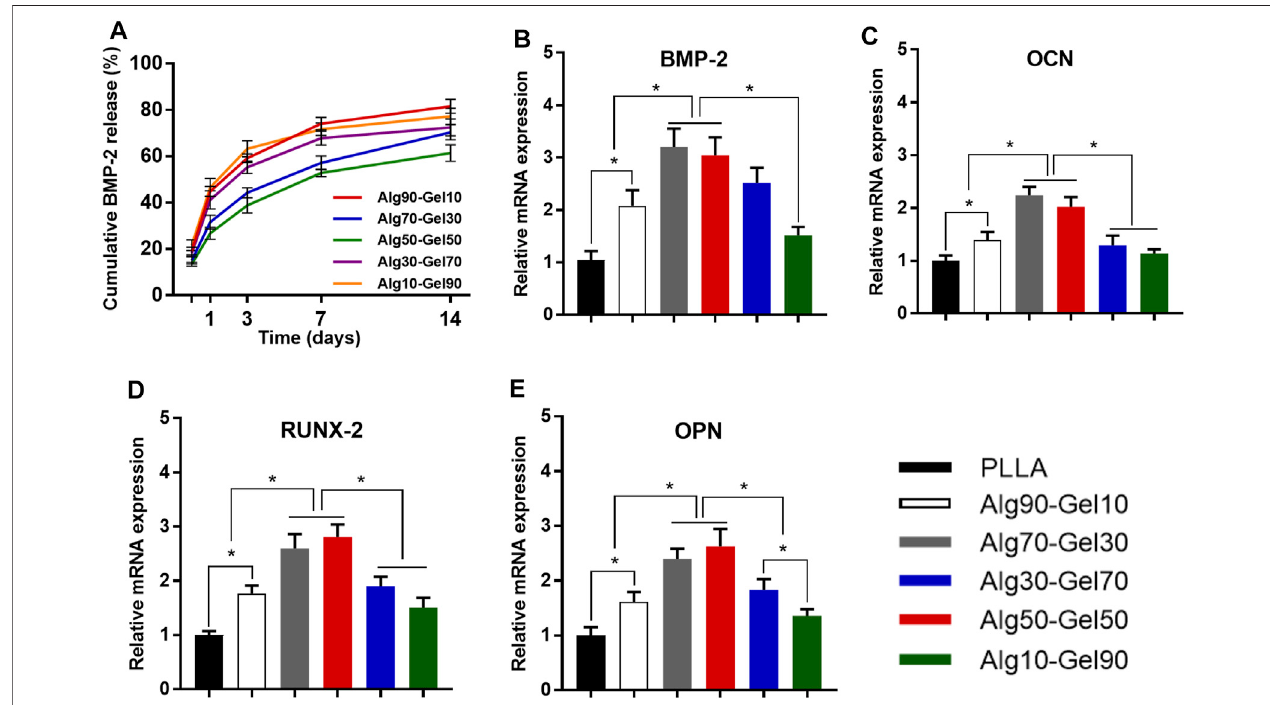
FIGURE 5 | (A) Release curves of BMP-2 from different double-crosslinked hydrogels. The mRNA levels of (B) BMP-2, (C) OCN, (D) RUNX-2, and (E) OPN were quanti fi ed from hBMSCs cultured in various substrates (* p < 0.05 compared with the control).